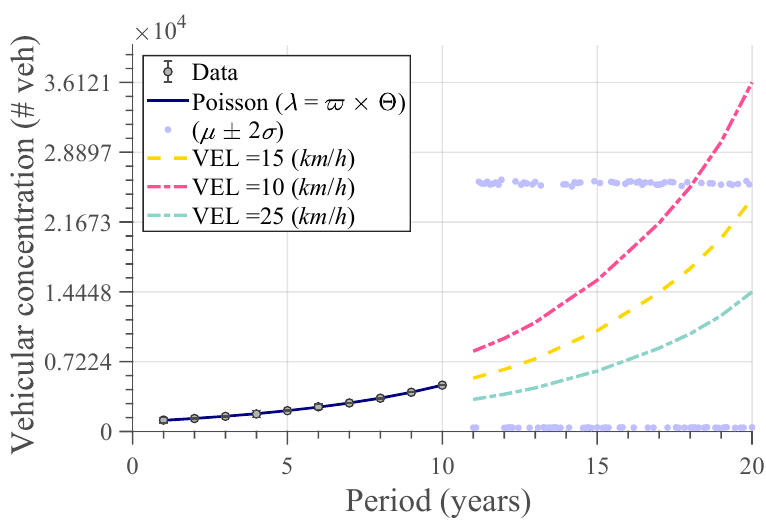
Figure 3. Heterogeneous time zone vehicle traffic average of 5 working